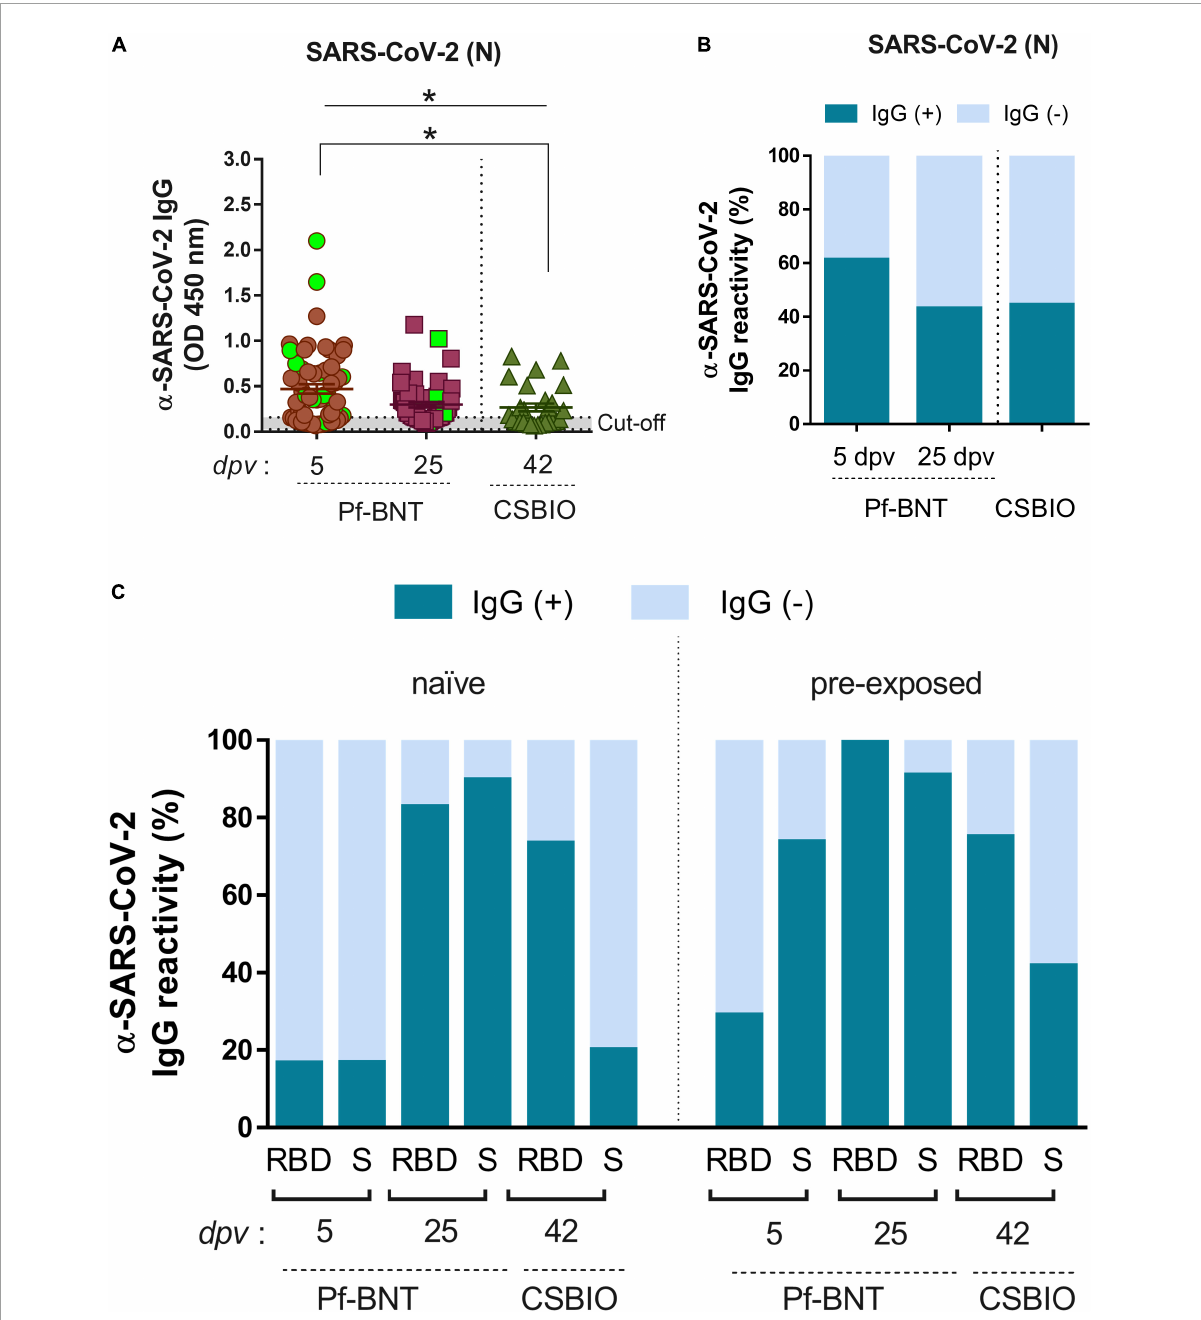
FIGURE3 IgG-specific responses to SARS-CoV-2 after natural infection. (A) IgG levels expressed as OD values against SARS-CoV-2 N protein determined from positive and negative serum samples based on previously established cut-off values > 0.20 (horizontal dotted line and gray zone ). Serum samples for Pf-BNT and CSBIO vaccinees were collected after 5 ( n = 62) and 25 ( n = 51), and 43 ( n = 27) dpv, respectively [vaccine values separated by vertical dotted line ( x -axis)]. Mann–Whitney test: * p < 0.05. n.s., non-significant differences. Each group of data in the scatter plots represent absorbance values (OD) obtained from individual serum sample per vaccine group including the mean ± SEM (standard error) of individual groups. Participants with record of COVID-19 (PCR-positive test) before vaccination are highlighted in light green. Stacked bars represent (B) total percentage of serum samples per vaccine group showing IgG positive (+, green ) or negative (–, light blue ) OD values against SARS-CoV-2 N protein and (C) the IgG reactivity to RBD and S in naïve (no-previously exposed) or pre-exposed vaccinees to SARS-CoV-2